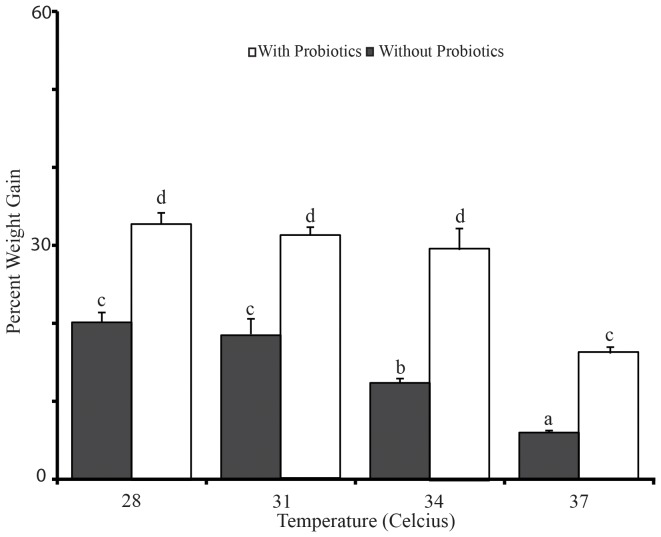
Effect of temperature and probiotic supplementation on percentage body weight gain of Labeo rohita fingerlings at the completion of the experiment.Significance between the treatments was determined by Duncan's Multiple Range Test (DMRT) using SPSS (Version 16.0). Similar alphabets (a,b,c,d) denotes no significance at P<0.01. Each value represents Mean ±SE of three biological replicates (n = 3), each replicate prepared from four fish. Briefly, data from four fish of one treatment replicate were averaged and used as one biological replicate. Similarly, three biological replicates (n = 3) were prepared, each from one treatment replicate.